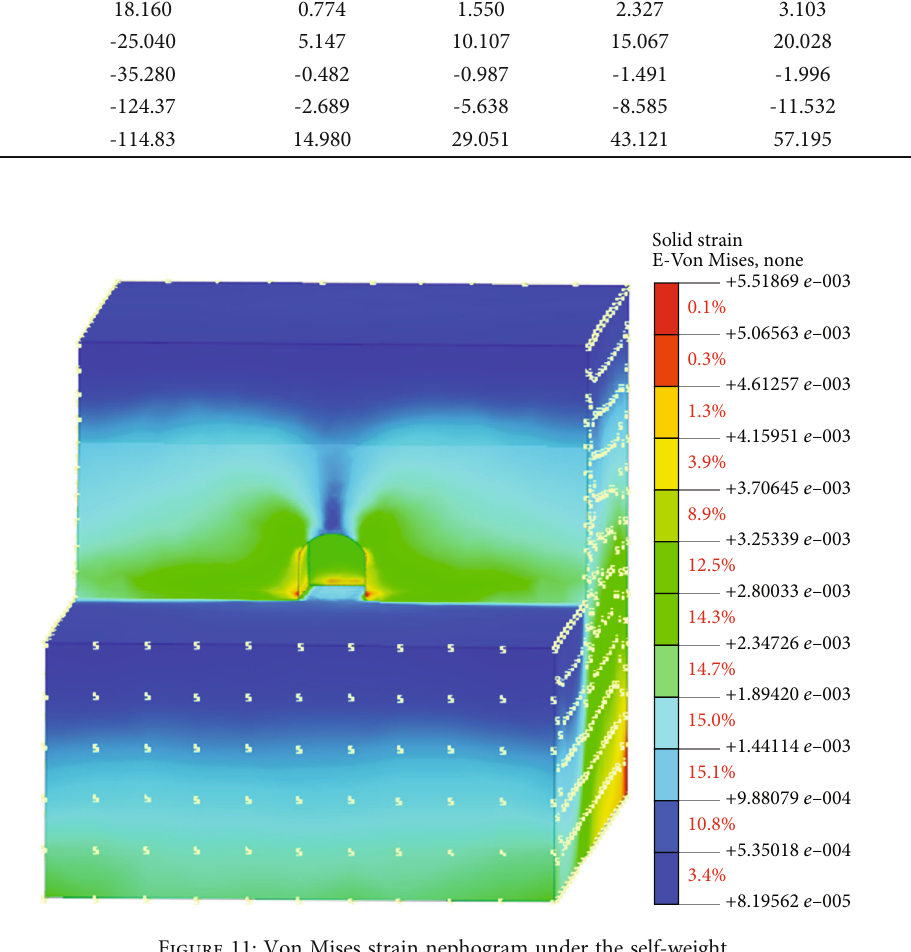
Figure 11: Von Mises strain nephogram under the